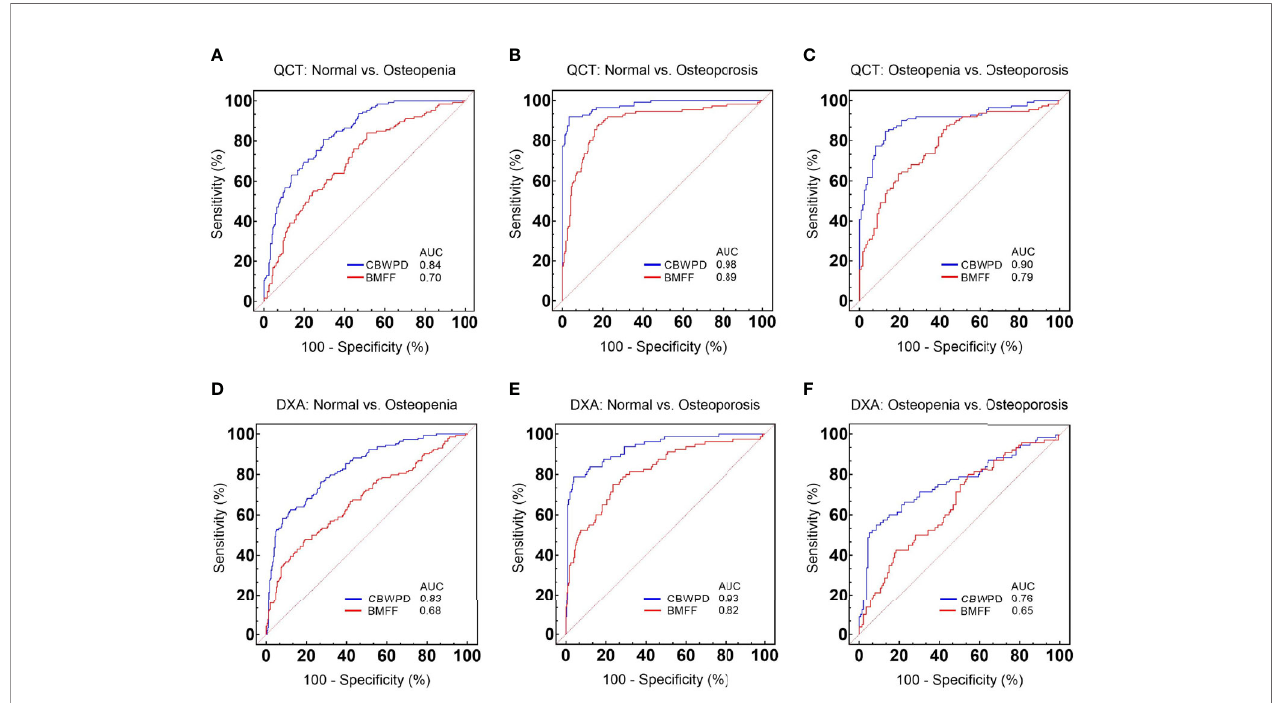
FIGURE 4 | Receiver operating characteristic (ROC) curves and corresponding area under the curve (AUC) values of collagen bound water proton density (CBWPD QCT ) and bone marrow fat fraction (BMFF QCT ) between (A) normal and osteoporosis, (B) normal and osteopenia, and (C) osteopenia and osteoporosis, with quantitative computed tomography (QCT) as reference standard. ROC curves and corresponding AUC values of CBWPD DXA and BMFF DXA between (D) normal and osteoporosis, (E) normal and osteopenia, and (F) osteopenia and osteoporosis, with dual-energy X-ray absorptiometry (DXA) as reference standard.